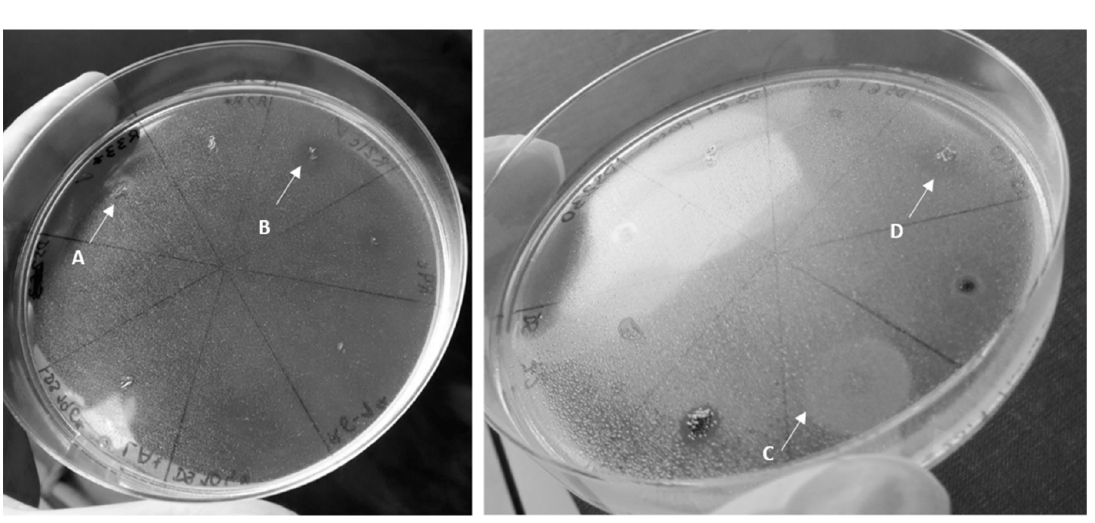
Figure 2. Photographs depicting examples of results of the atomized oil assay for plates incubated in the anaerobic jar. On the left, an LA plate with a bright halo for isolate R33 (A) and a dark halo for R21 (B), both positive results. On the right, a MB2216 plate with a bright halo for the positive control of SDS 25% (C) and a dark halo for DS140 (D).